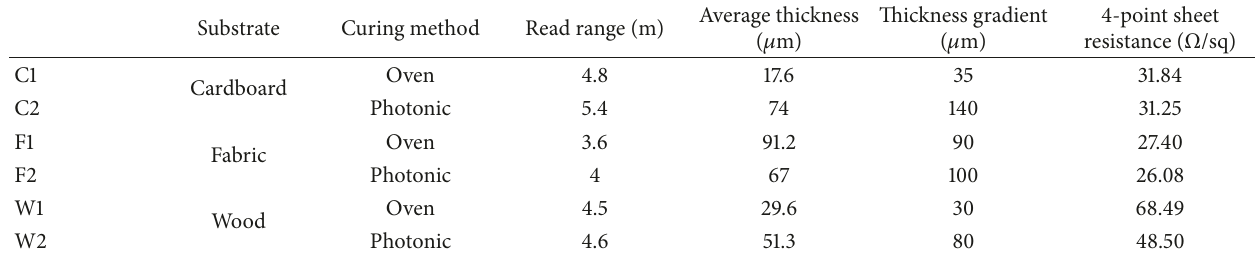
Table 3: The peak read range of each tag antenna together with the corresponding thickness, average thickness gradient, and sheet